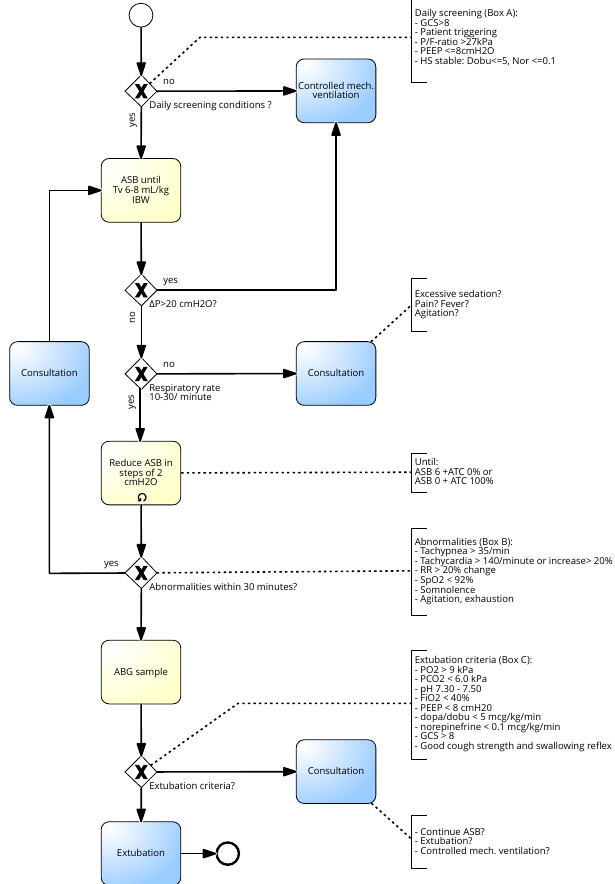
Figure 4. The weaning protocol used in the case